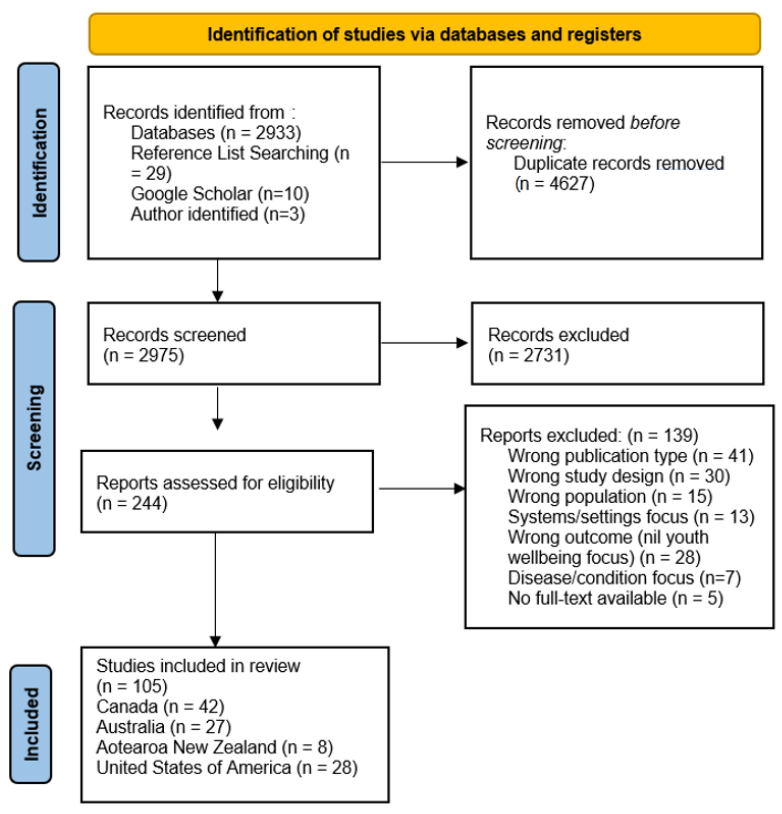
Figure 1. Preferred Reporting Items for Systematic Reviews and Meta-Analyses (PRISMA) Flowchart.